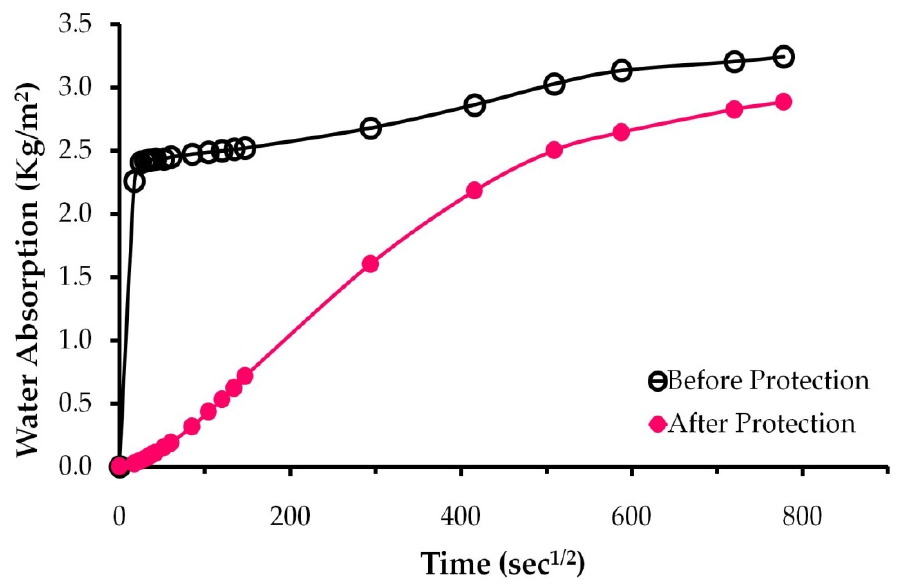
Figure 5. Curves of water absorption by capillarity before and after the PT 3 treatment.